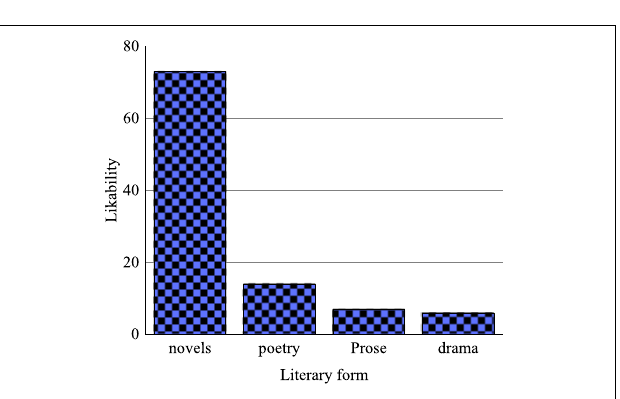
prose and drama are chosen by less than 10%. Apparently, AAL novels are the favorite of respondents in terms of literature form (Larissa et al., 2020).